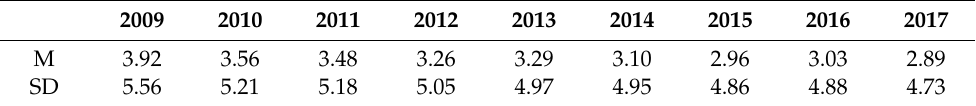
Table 2. Means and standard deviations of the AUDIT scores between 2009 and 2017.